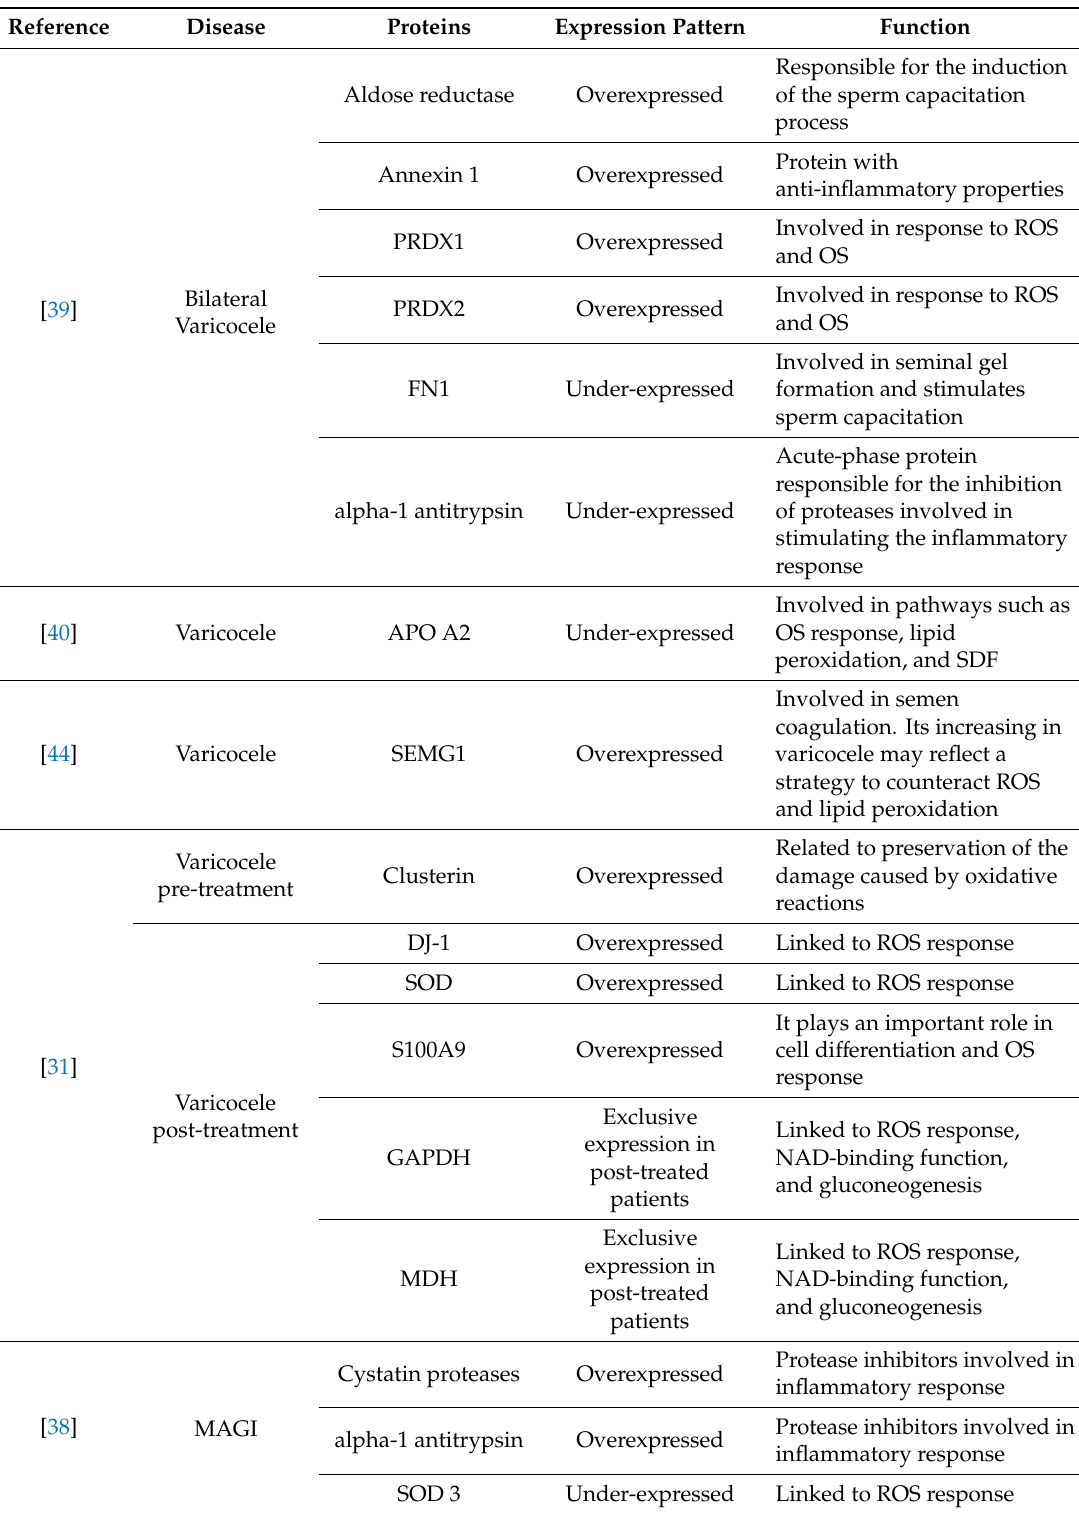
Table 2. Expression pattern and function of proteins involved in the response to ROS in diseases associated with increased oxidative